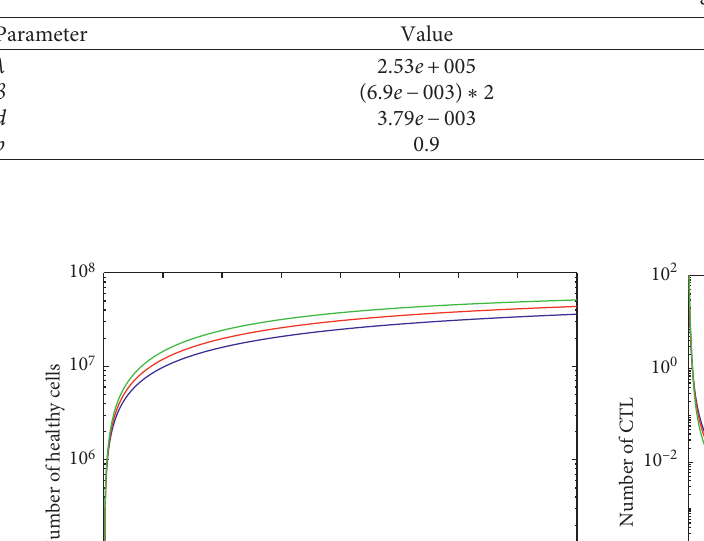
Figure 2: Simulation results of successful-treatment group. Table 5: Parameters in Figure 3.